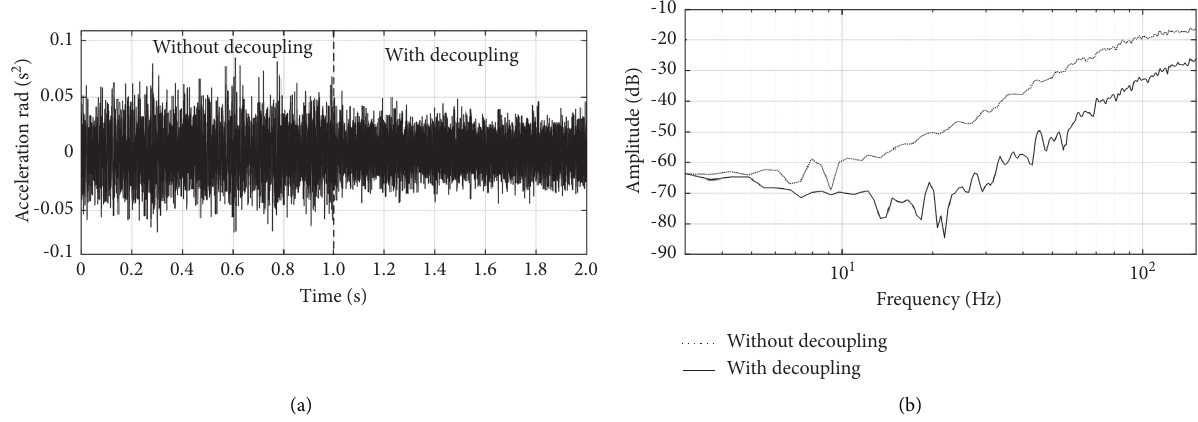
Figure 10: Comparison of random signal before and after decoupling with eccentric load. (a) Acceleration and (b) frequency domain waveform.